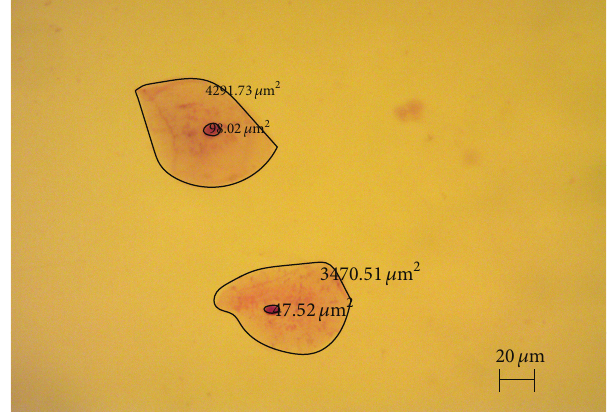
Figure 1: The encirclement of the nuclear and cytoplasmic bound- aries of the cells on digitally obtained images ( ×